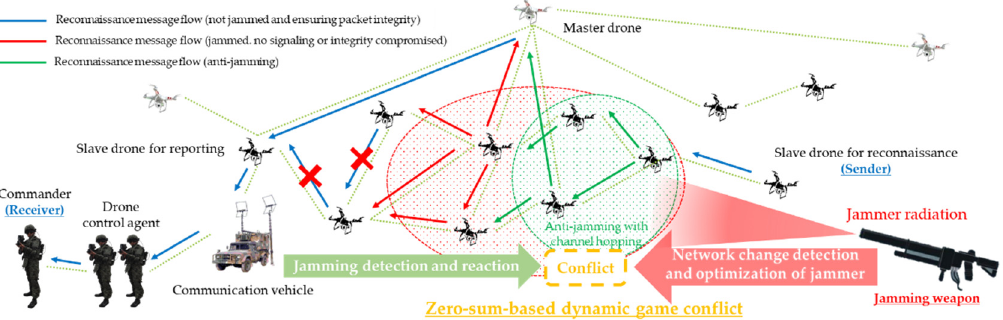
Figure 7. Anti-jamming scenarios for multi-layered jamming that interfere with reconnaissance reports within a swarming communication drones maneuvering system.